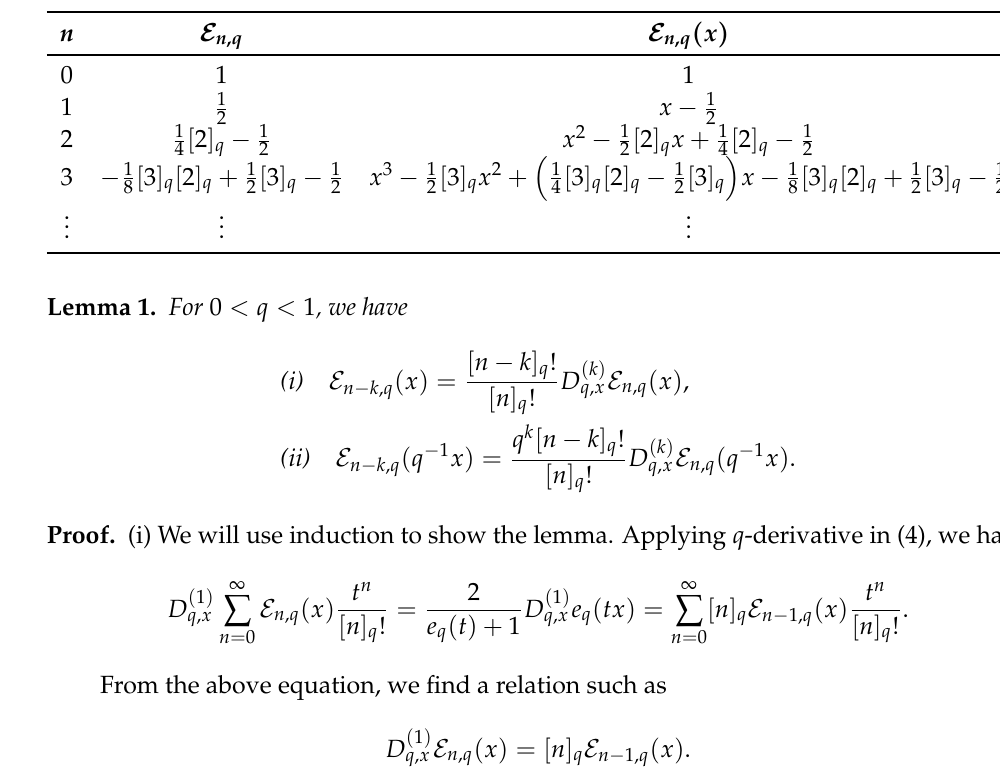
Table 1. q -Euler numbers and